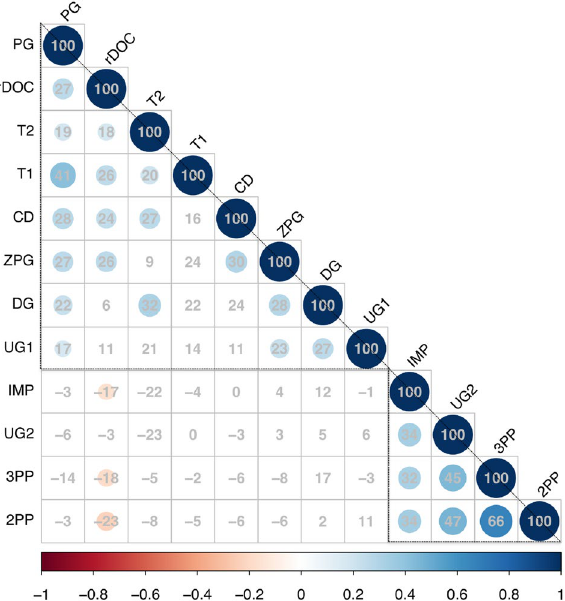
Figure 2. Spearman correlation matrix of behavior in game-theoretic paradigms. Colored cells represent significant correlations corrected with the Holm’s method. Numbers are correlation coefficients presented in percentages. Variables are ordered on the basis of the first principle component, triangles are manually super- imposed to highlight two potential groups of decisions. PG (contributions in a public good game), TG1 and TG2 (amounts entrusted and returned as 1st and 2nd mover in a trust game, respectively), rDOC (restraint in a dilemma of the commons), CD (amounts donated to charities), ZPG (frequency of helping choices in the Zurich prosocial game), DG (transfers in a dictator game), UG1 (offer size in an ultimatum game), UG2 (frequency of rejections in an ultimatum game), IMP (frequency of rejections in an impunity game), 2PP and 3PP (amount spent to punish norm violators in 2nd and 3rd party punishment